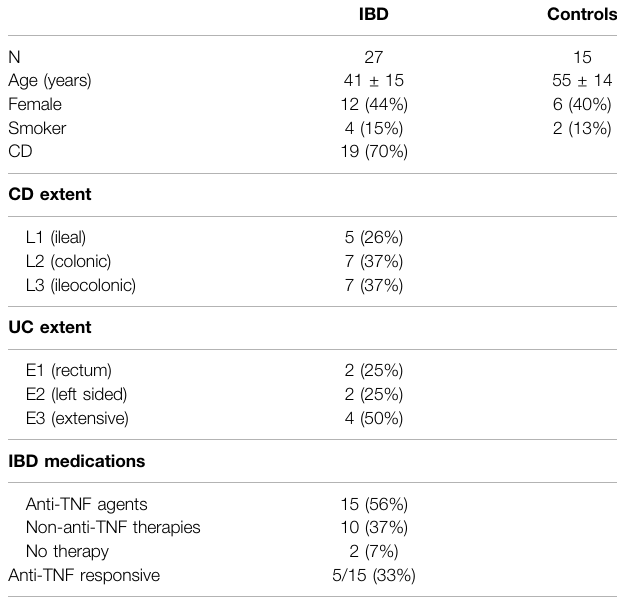
TABLE 1 | Patient